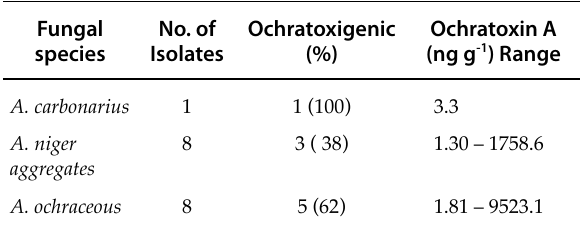
Table 4. Toxigenic potential of ochratoxigenic fungi iso- lated from maize.